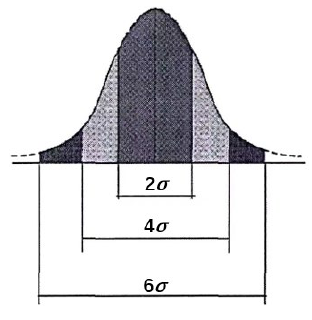
Figure 2. Stress interval. Table 1. Gaussian-distribution Steinberg method.